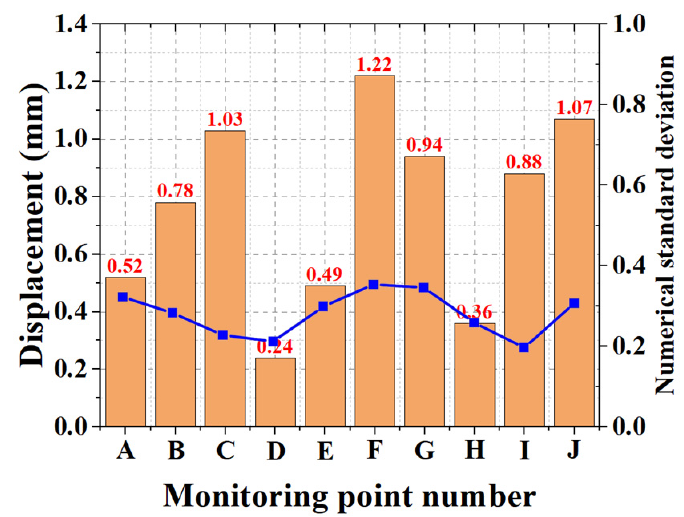
Figure 17. Monitoring-point displacement.